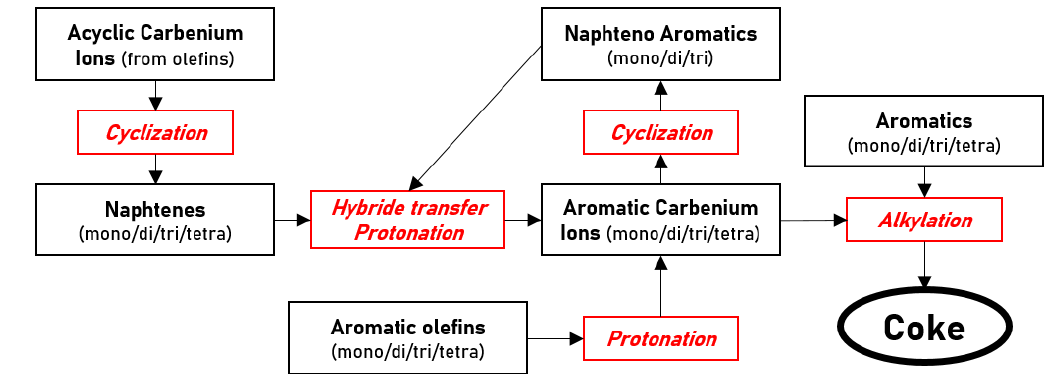
Figure 12. Reaction scheme for coke formation during catalytic cracking of VGO. Adapted from Moustafa et al. [84]. Black: chemical compounds. Red: reaction mechanisms.